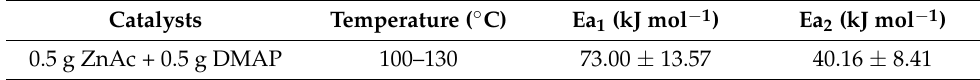
Table 6. The activation energies for each step of PLA